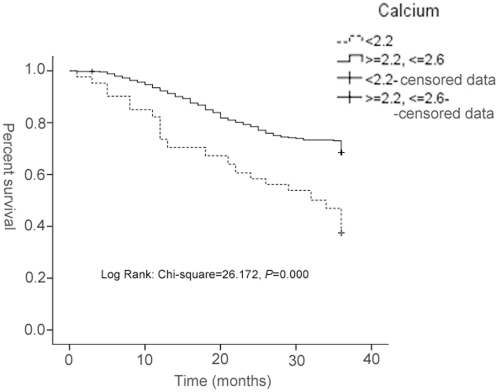
The Kaplan-Meier survival curve of NSCLC patients who underwent radical resection (n = 572).It is analyzed using Kaplan-Meier survival model, including 108 cases with blood calcium <2.2, and 464 cases with 2.2< = calcium< = 2.6. Log-rank comparisons revealed that blood calcium decrease(<2.2 µM) was associated with shorter survival (Log-rank; χ2 = 26.172, P<0.001).